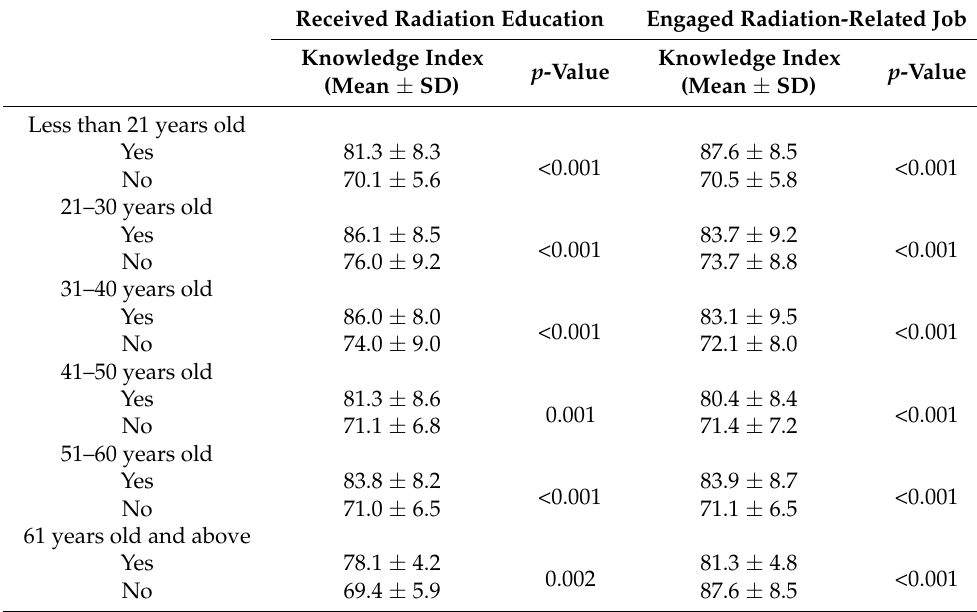
Table 3. The t -test results of received radiation education and engaged radiation-elated job within each age subgroup.